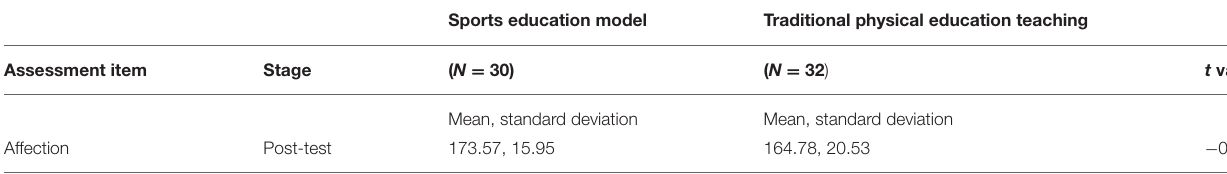
TABLE 8 | Comparing the two groups of teaching affection post-test learning effect t